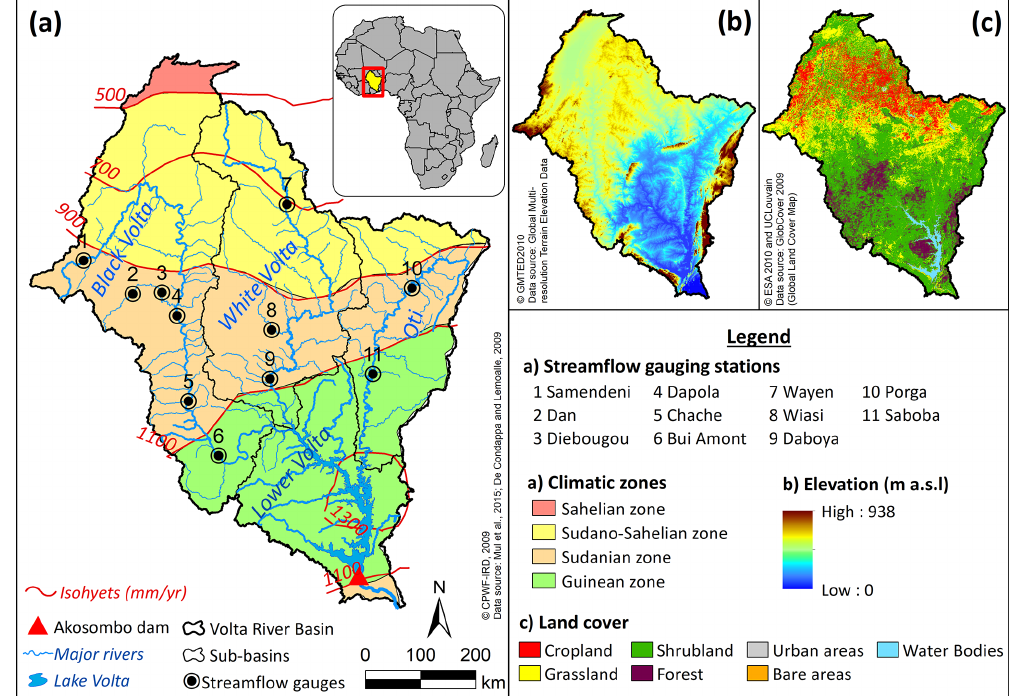
Figure 1. Physical and hydroclimatic characteristics of the Volta River basin. (a) Hydrographic network and climatic zones, (b) digital elevation model, and (c) land cover. Adapted from Dembélé et al. (2020b).